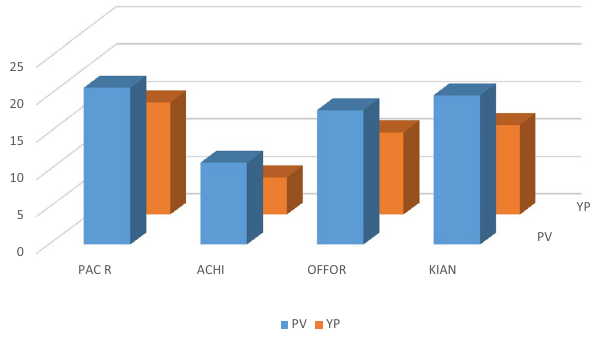
Fig. 3 Flow properties of the water based mud for each viscosifier